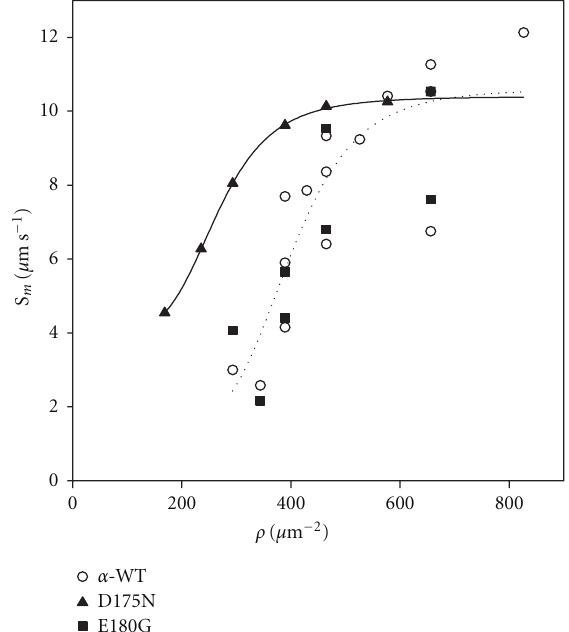
Figure 7: HMM density ( ρ ) dependence of maximum unloaded filament sliding speed ( s m ) of regulated thin filaments reconstituted with HcTn and either α -GS-Tm WT ( (cid:7) ), α -GS-Tm D175N ( (cid:3) ), or α -GS-Tm E180G ( (cid:4) ). s m was obtained at each ρ according to the method of Uyeda et al. [61] as described in Section 2.8; each point is from one flow cell. Note that s m ( ρ ) for thin filaments containing α -GS-Tm D175N is shifted leftward of that for thin filaments containing either α -GS-Tm WT or α -GS-Tm E180G.